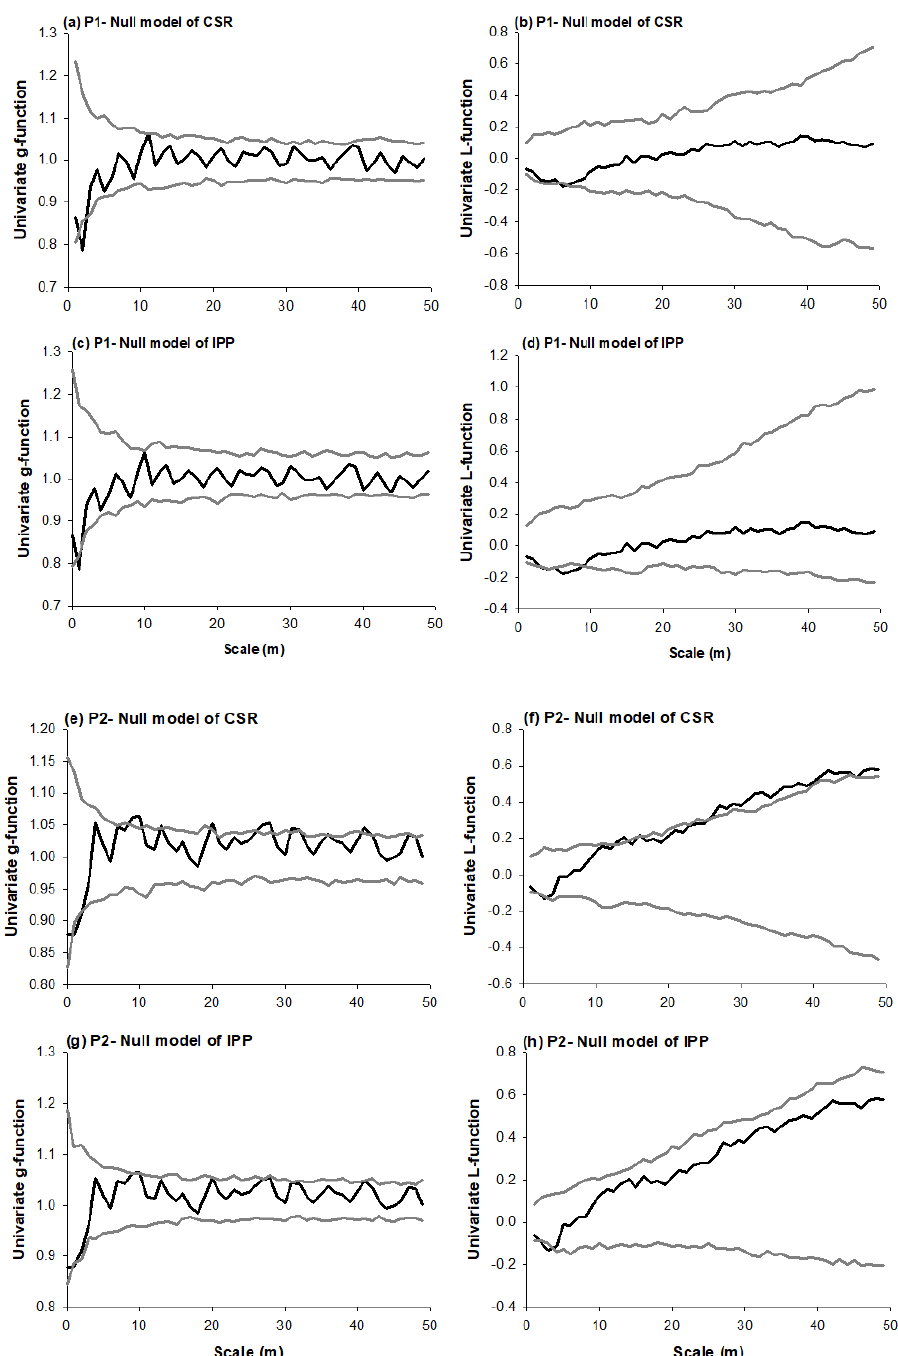
Figure A1. Spatial patterns of all trees with DBH ≥ 10 cm in two plots P1 and P2 using univariate pair-correlation g -function ( a , c , e , g ) and L -function ( b , d , f , h ). Null models were CSR ( a – b , e – f ) and IPP ( c – d , g – h ) with R = 50 m. In the P1, the g -function and L -function showed no large scale departure from the null model of CSR ( a , b ) indicating environmental homogeneity. In the P2, the g -function was significant (>1) for scales larger than 10 m ( e ), the L -function showed a clear departure from scales r > 25 m and did not approach value 0 ( f ) under the null model of CSR. Moreover, the spatial arrangement of trees >10 cm fitted very well under the null model of IPP with R = 50 m ( c – d , g – h ) when analyzed by the g - and L -functions. These evidences significantly exhibited large scale homogeneity at P1 and heterogeneity at P2. Note: L -function is a transformation of Ripley’s K-function, L ( r ) = ( K ( r )/π) 0.5 − r . The g pair-correlation function is the derivative of the K function, g ( r ) = K’ ( r )/(2π r ) and r is radius of the circle from a randomly chosen tree (please see more details about K function in [23]).